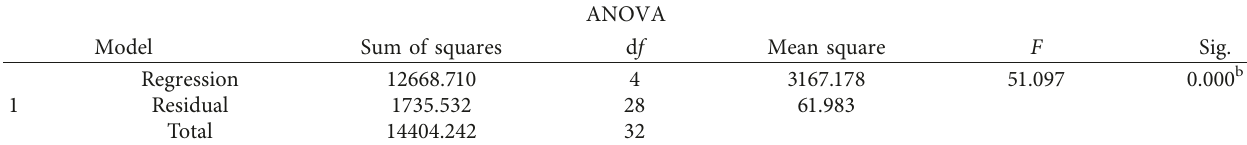
Table 3: ANOVA regression.